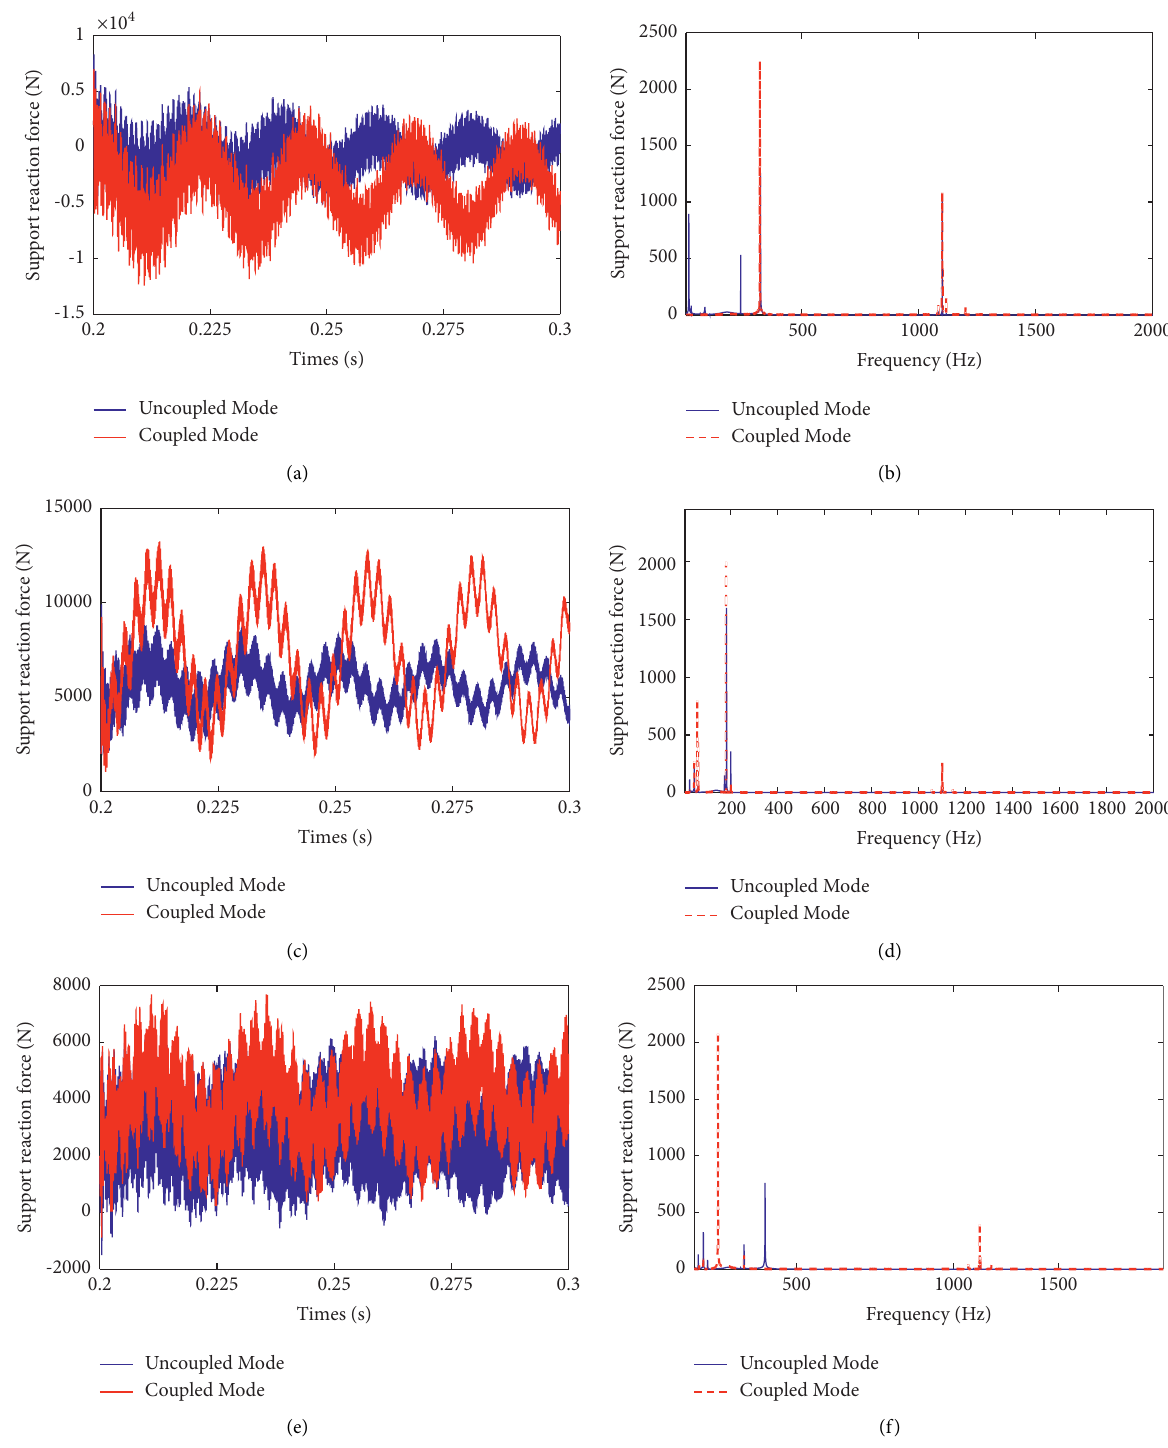
Figure 23: The bearing support force in two modes. (a) Time-domain diagram of bearing 1 support force. (b) Frequency domain diagram of bearing 1 support force. (c) Time-domain diagram of bearing 5 support force. (d) Frequency domain diagram of bearing 5 support force. (e) Time-domain diagram of bearing 9 support force. (f) Frequency domain diagram of bearing 9 support